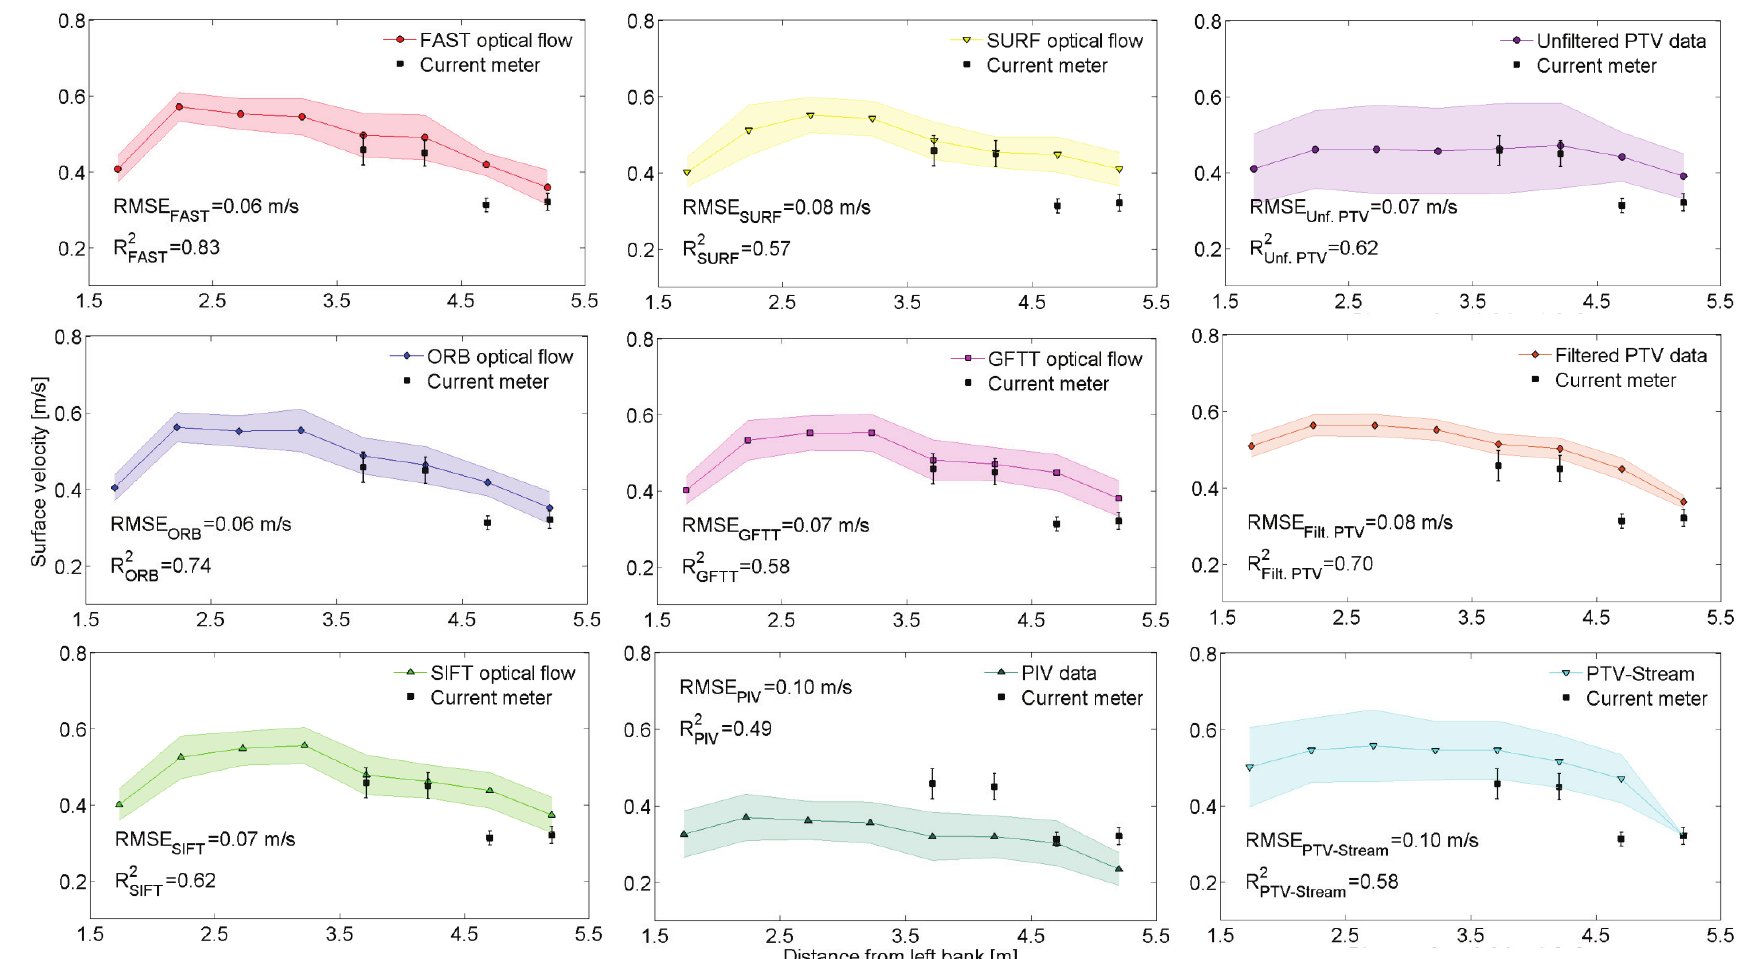
Figure 7. Time-averaged surface flow velocity cross-sectional profiles obtained by processing the 12 image sequences on the Brenta River with all approaches. RMSE and R 2 values computed between each method and the current meter data are